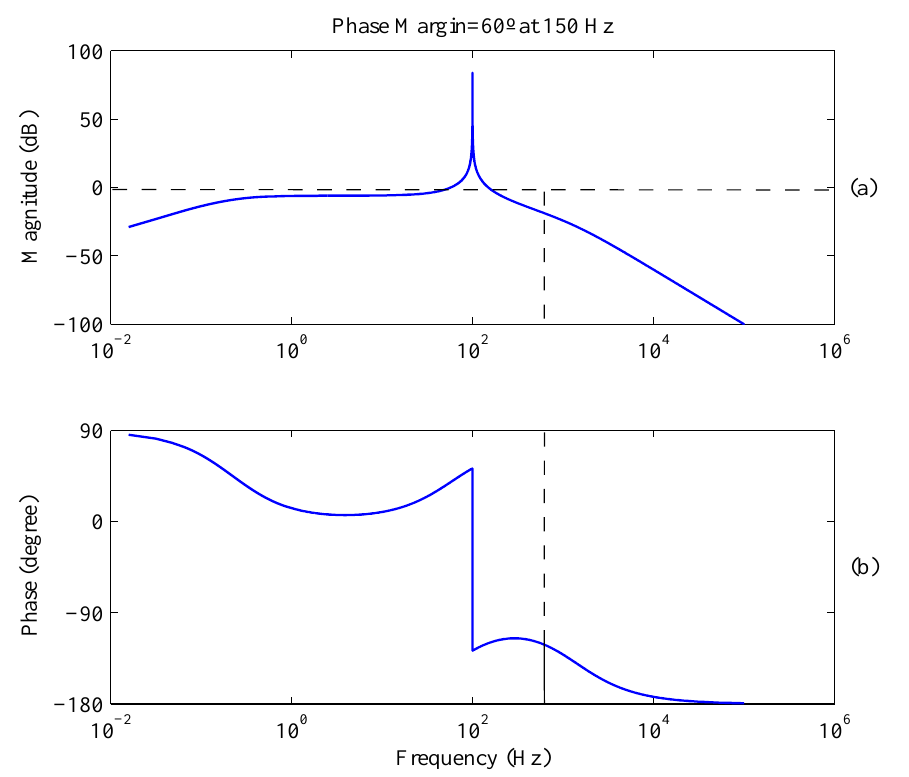
Bode diagrams of the frequency response of the open-loop system: ( a ) magnitude and ( b )